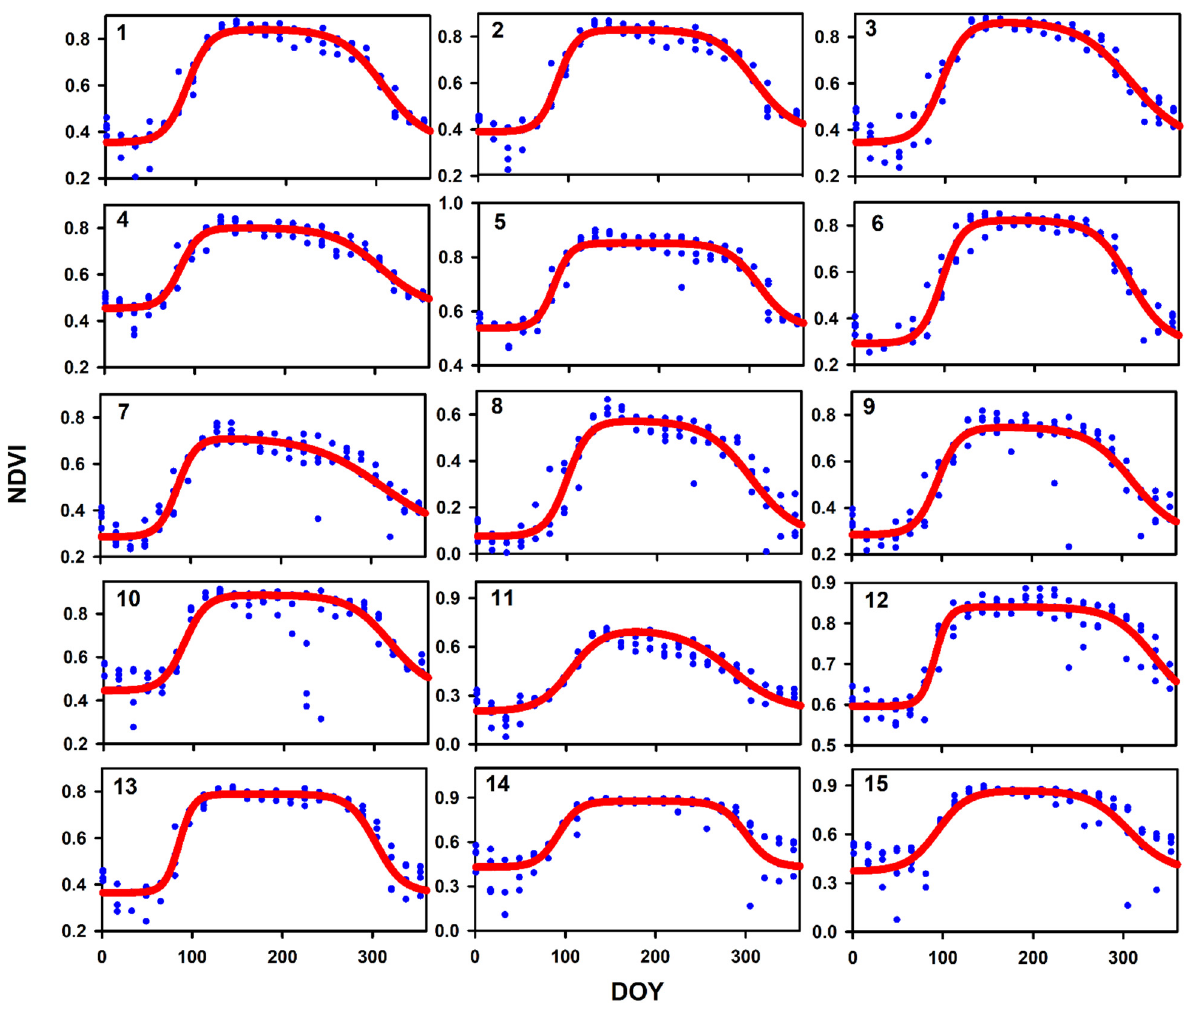
Figure 3. Double logistic fitting of time series (averaging 2017 to 2020) MODIS NDVI data for the 15 forest sites. Blue dots represent the raw points of MODIS NDVI data, and red line is a fitted line. Site numbering from 1 to 15 corresponds to Figure 1 description of each World Heritage Site.